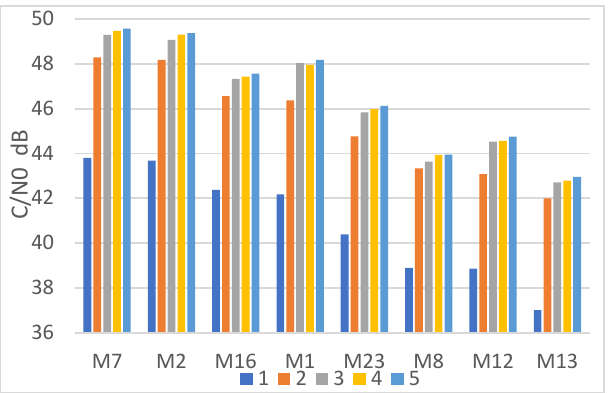
Figure 14. The estimated value of C/N0 in different tracking modes for the B1C.